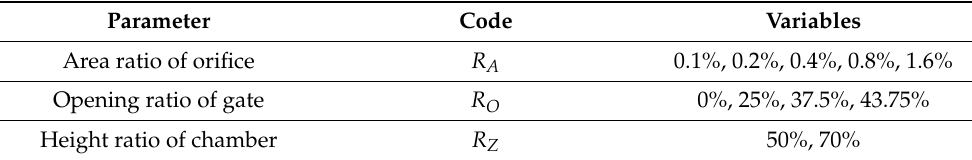
Table 2. Parameters utilized in the experimental